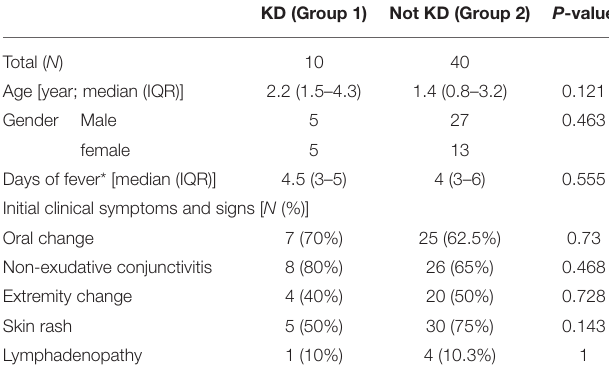
TABLE 1 | Patients’ characteristics and clinical symptoms and